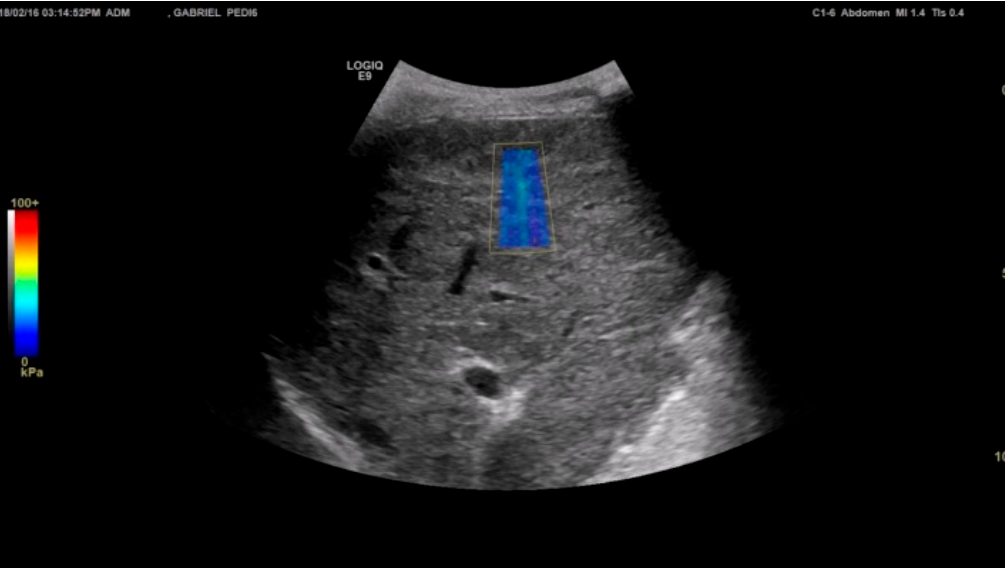
Figure 1 . Two-dimensional shear wave elastography (2D-SWE) in a 10 years old boy with cystic fibrosis associated liver disease. The median of liver stiffness measurements using the convex probe was 4.47 kPa, IQR = 1.13. Point SWE results were 1.47 m/s (convex